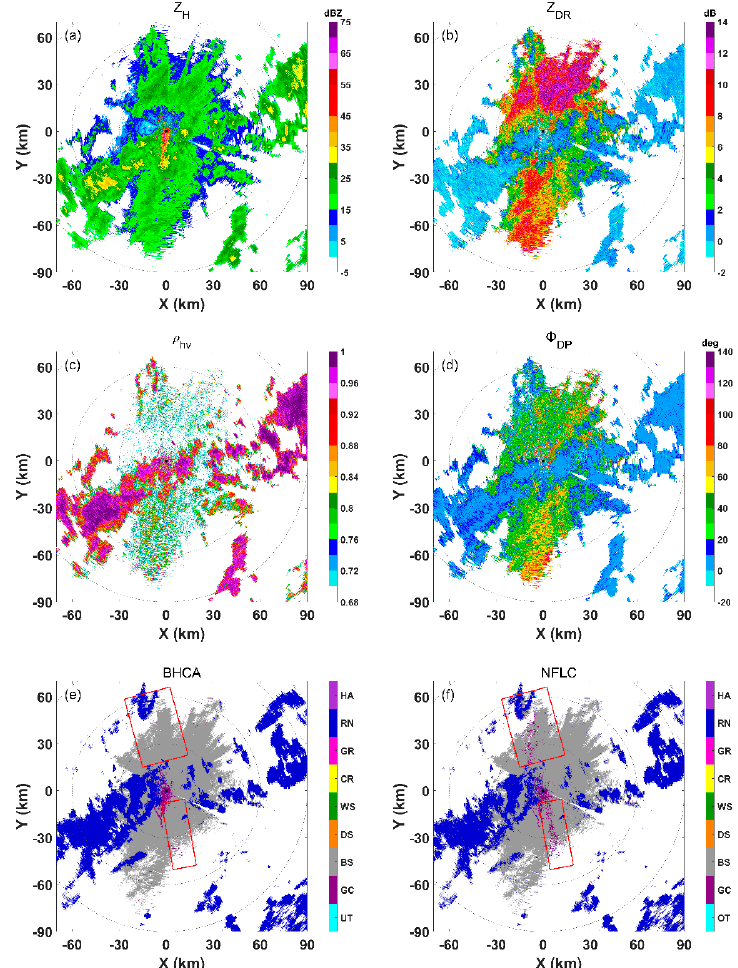
Figure 6. Plan position indicator (PPI) of ( a ) Z H , ( b ) Z DR , ( c ) ρ hv , ( d ) Φ DP , and corresponding hydrometeor classification results by ( e ) the Bayesian hydrometeor classification algorithm (BHCA) and ( f ) NCAR fuzzy logic classifier (NFLC) at 0.5 ° elevation angle at 08:03 LST on 24 July 2014 and hydrometeor classification results. The red rectangle highlights the different output classification.